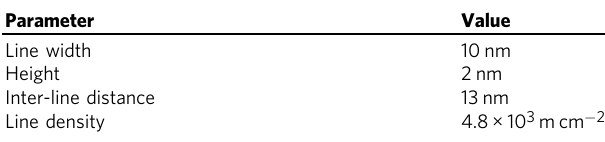
Table 1 Geometric parameters of fabricated